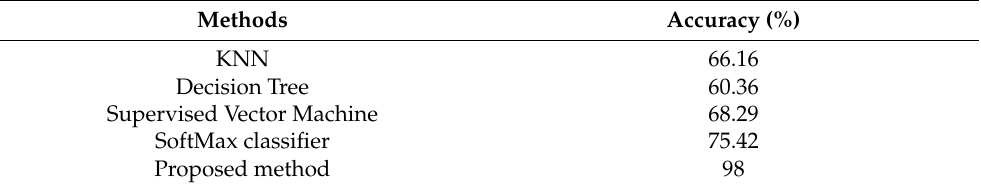
Table 7. Analysis of accuracy [35].